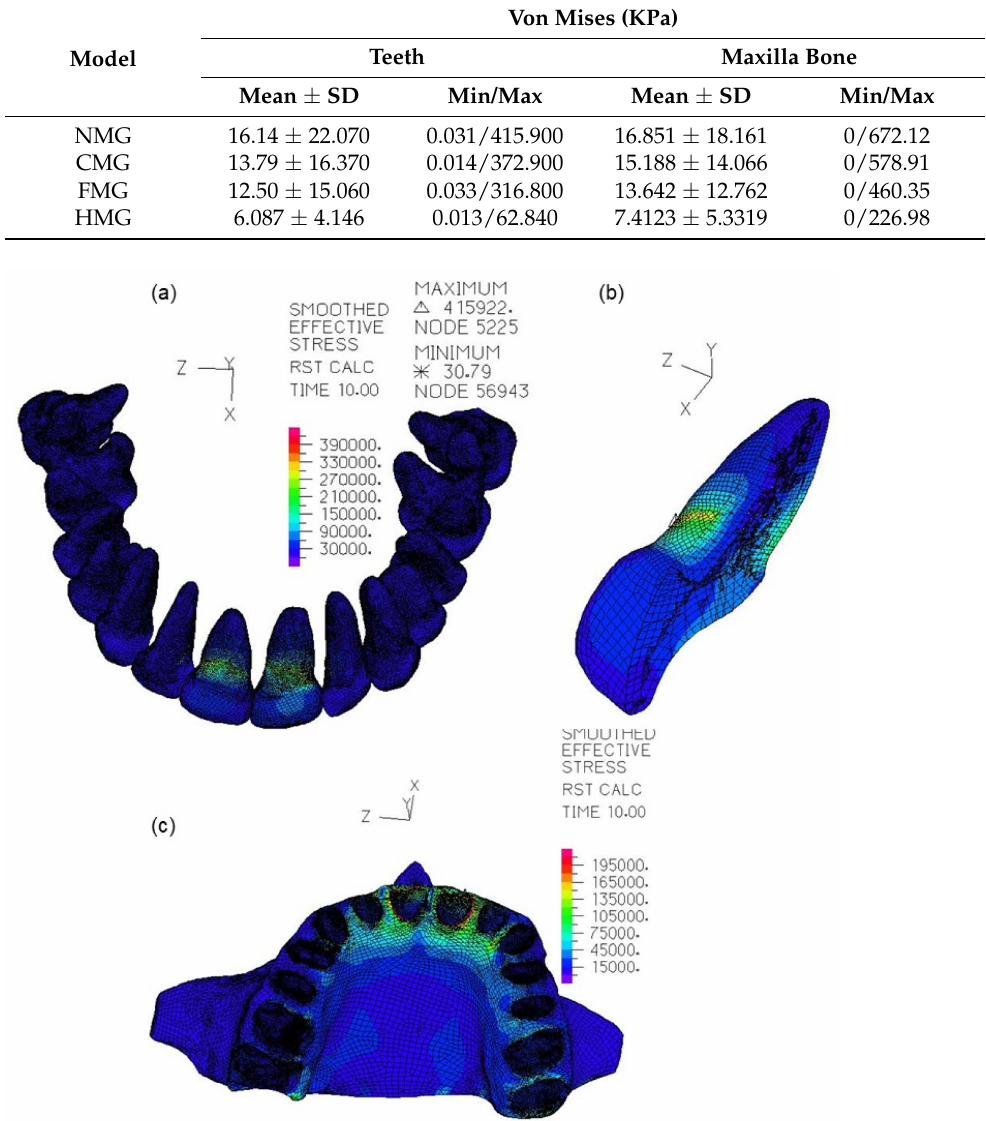
Figure 9. Von Mises stress distribution for the NMP model: ( a ) in the teeth; ( b ) central incisor cut; ( c ) maxilla